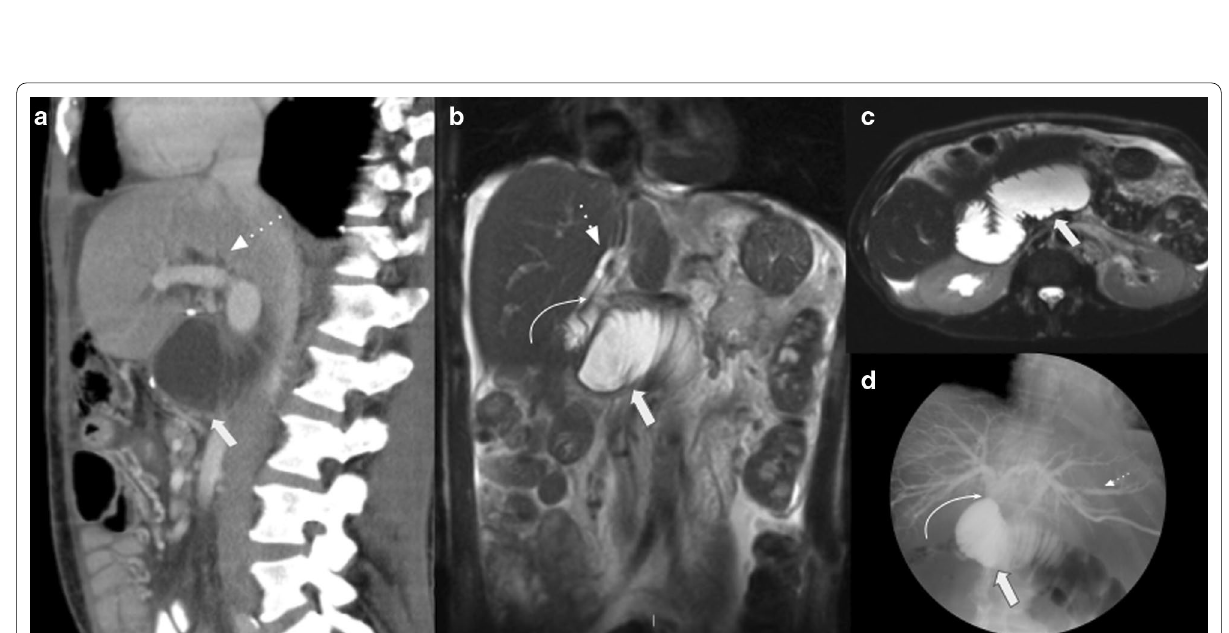
Fig. 25 Afferent limb syndrome. 55-year-old male patient with Y de Roux reconstruction during abdominal pain and jaundice. Multimodality imaging assessment revealed marked distension of afferent limb (big arrow). Hepaticojejunostomy was permeable (curved arrow in b and d ), and intrahepatic biliary dilatation is also noted (dotted arrows in a , b and d ). Surgery confirmed afferent limb syndrome caused by limb stricture near entero-enteric